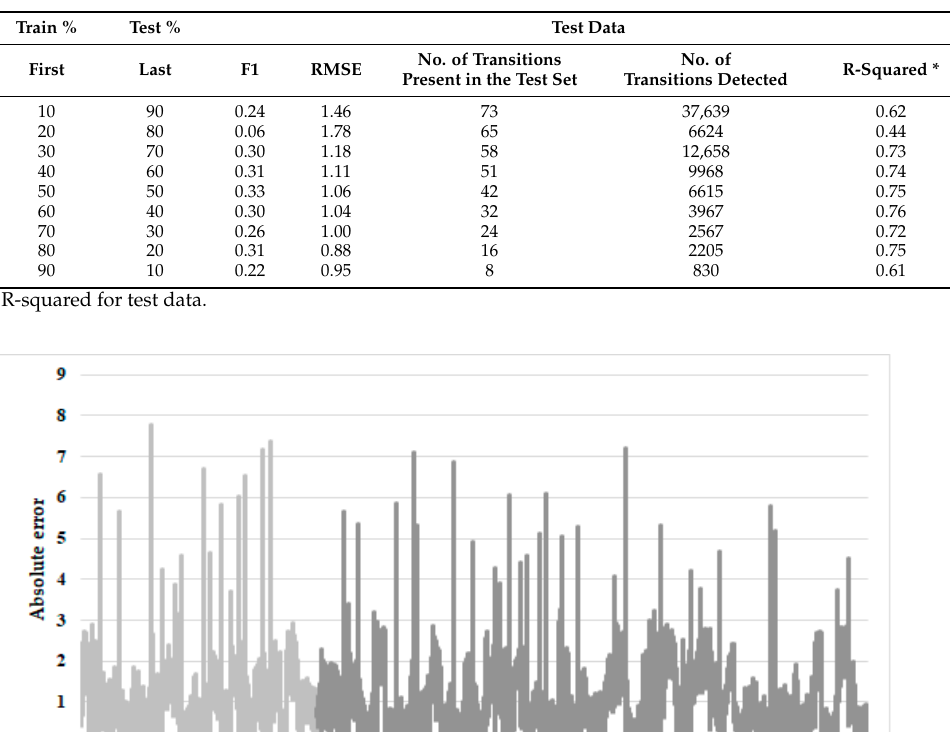
Table 7. Forecasting efficacy of the two-state Markov-switching effects dynamic regression model for different training and testing partitions.